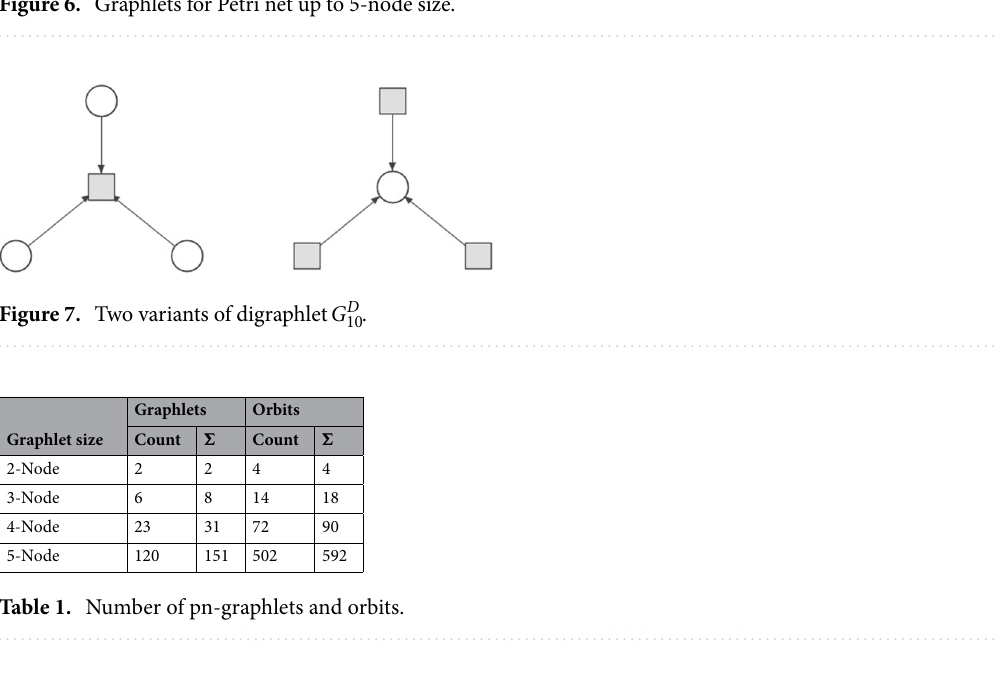
Figure 6. Graphlets for Petri net up to 5-node size.